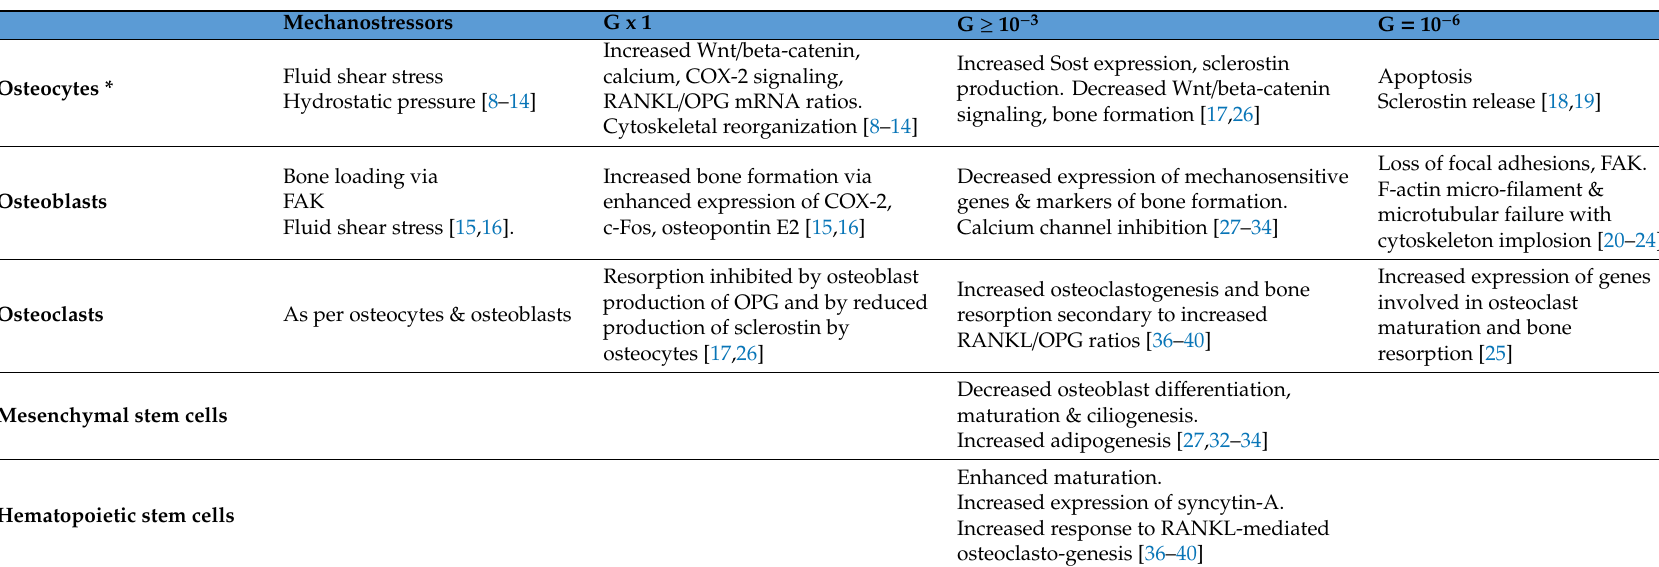
Table 1. E ff ects of gravity on osteocyte, osteoblast, osteoclast and mesenchymal and hematopoietic stem cell